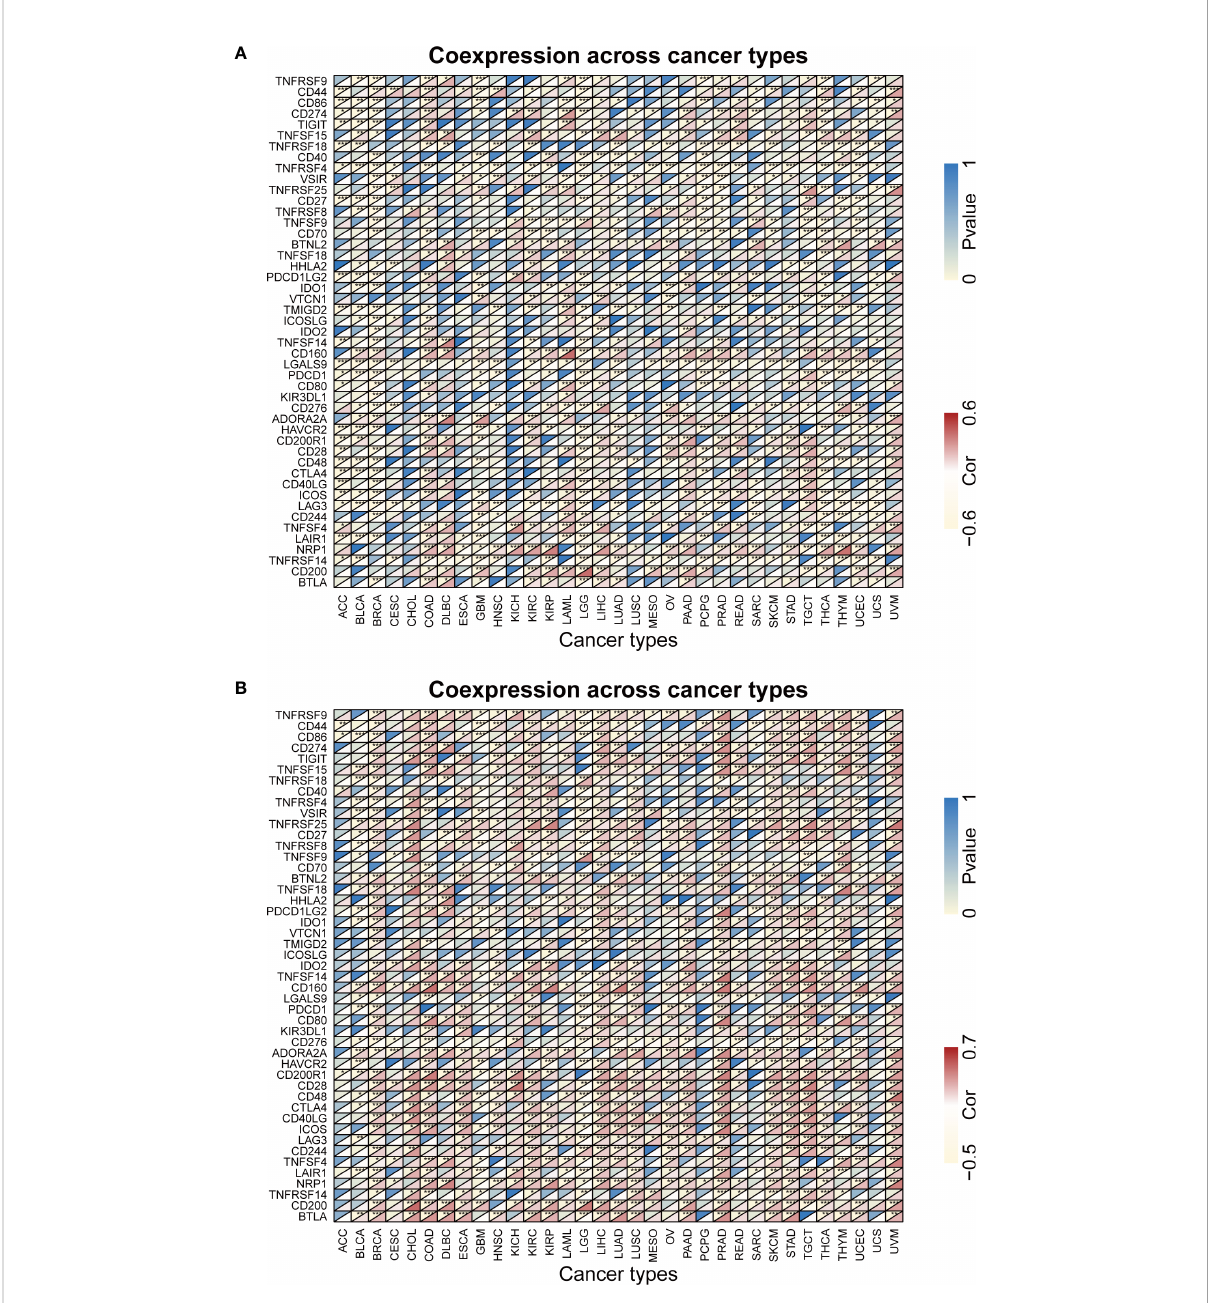
FIGURE 12 The relationship between FBXW1/FBXW7 and immune checkpoints. (A) Heatmap illustrating the relationship between FBXW1 and known immune checkpoints. (B) Heatmap illustrating the relationship between FBXW7 and known immune checkpoints. ∗ P< 0.05, ∗∗ P< 0.01, and ∗∗∗ P<